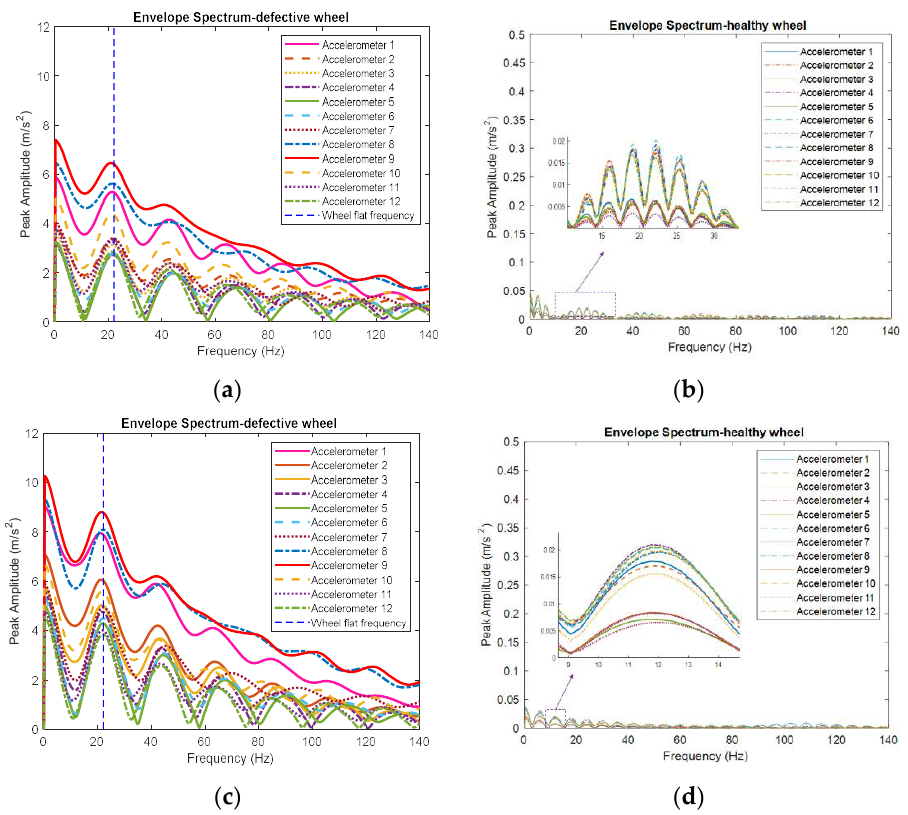
Figure 11. Envelope spectrum analysis for the 12 accelerometers (layout scheme 2) for the Alfa Pendular and the freight wagon, considering the unevenness profile of the track for ( a ) a defective wheel Alfa Pendular, ( b ) a healthy wheel Alfa Pendular, ( c ) a defective wheel freight wagon, and ( d ) a healthy wheel freight wagon.